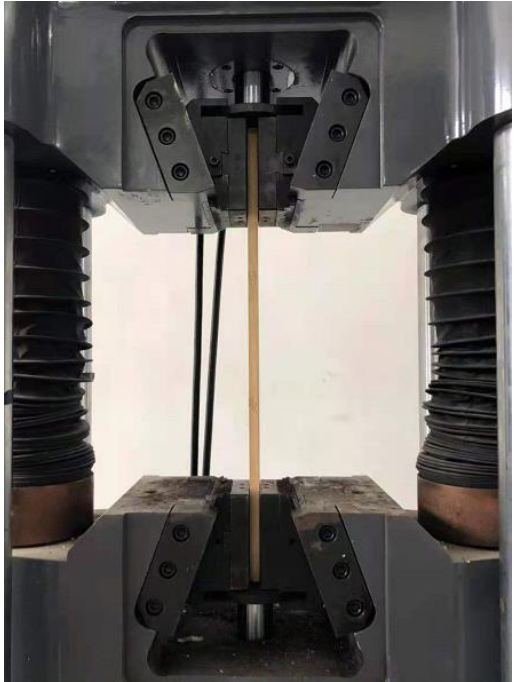
Figure 3. Test photo of tensile testing.